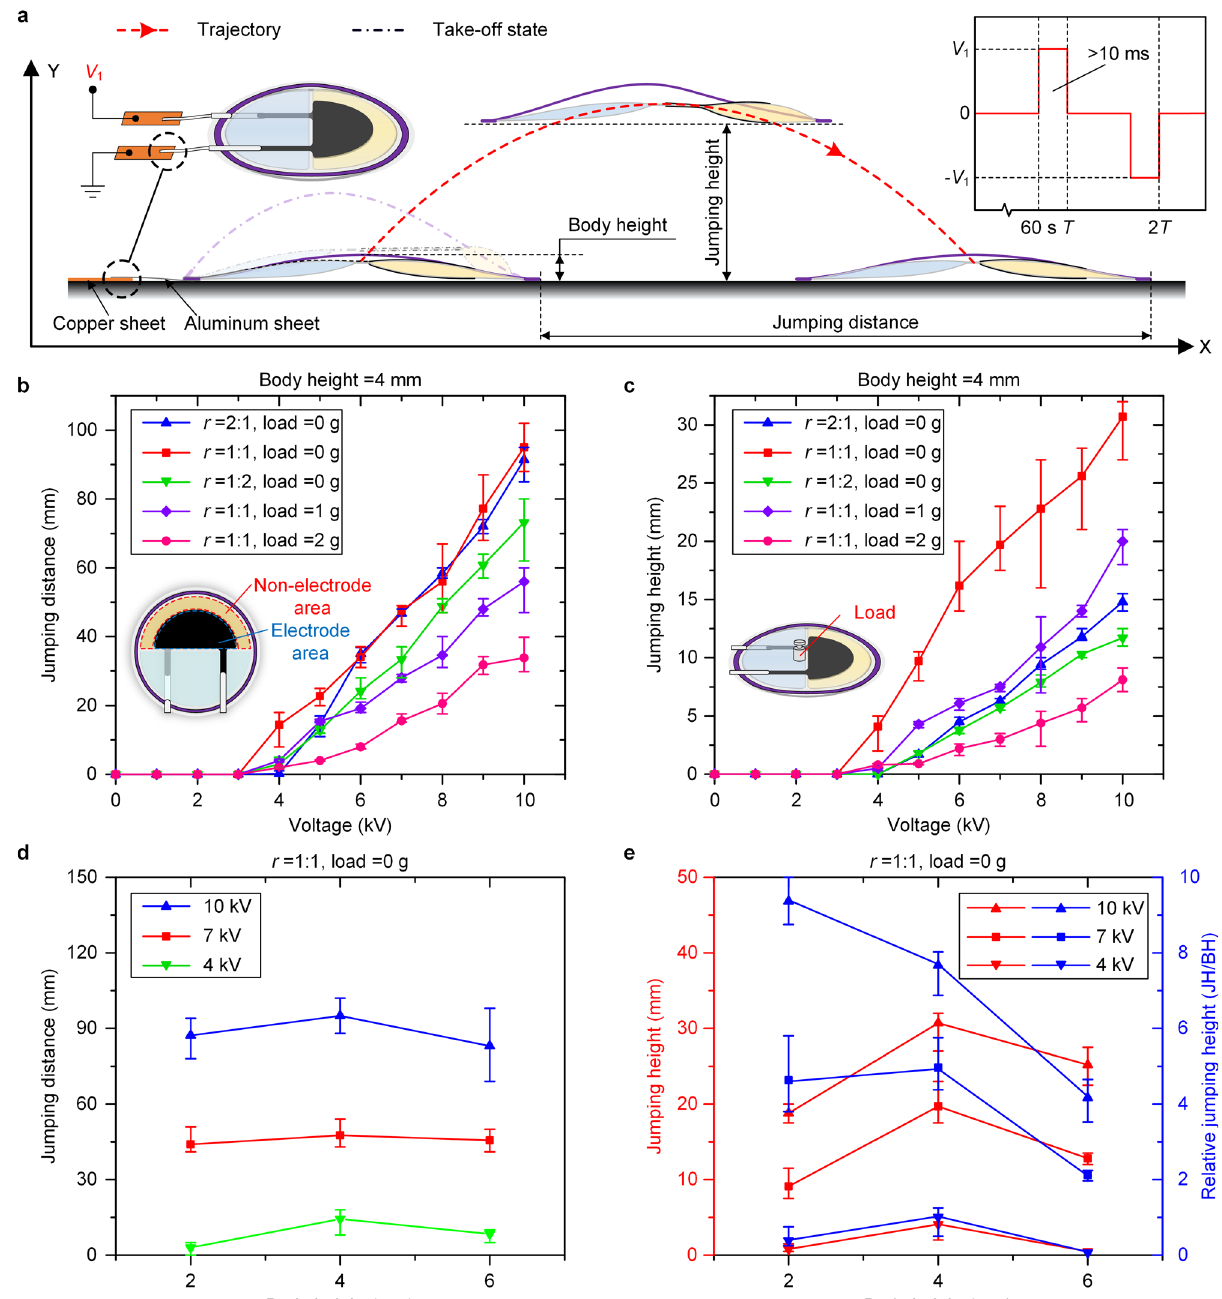
Fig. 2 Single-jump characterization results. See also Supplementary Movie 2. a Untethered single-jump process and parameters. The top left inset shows the electrical connections. The top right inset is the voltage application strategy in the experiment. b The relationship between JD and applied voltage under different loads (0, 1, and 2 g) and different electrode area/nonelectrode area ratios (2:1, 1:1, and 1:2). c The relationship between JH and applied voltage under different loads (0, 1, and 2 g) and different electrode area/nonelectrode area ratios (2:1, 1:1, and 1:2). d The relationship between JD and applied voltage at different body heights (2, 4, and 6 mm). e The relationship between JH, RJH, and applied voltage at different body heights (2, 4, and 6